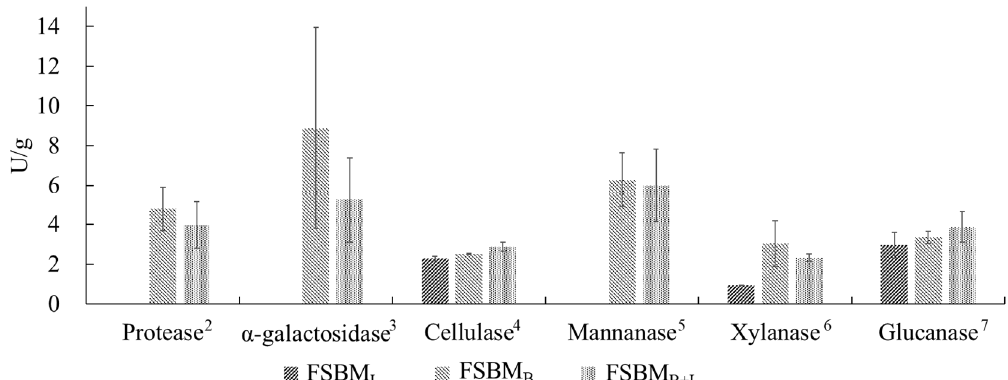
Figure 1. Enzymes activities of FSBM products. 1 Each value represents the mean ± standard deviation (n = 3). 2 One unit was defined as the hydrolysis of 1 mg mL − 1 azocasein to change the absorbance by 0.001. 3 One unit was defined as 2 mM p-Nitrophenol α -D-Galactopyranoside hydrolysis to release 1 µ M p-nitrophenol. 4 One unit was defined as the consumption of 5 mg mL − 1 CMC to generate 1 μ M of reducing sugar. 5 One unit was defined as the consumption of 3 mg mL − 1 locust bean gum to generate 1 μ M of D-mannose. 6 One unit was defined as the consumption of 10 mg mL − 1 beechwood xylan to generate 1 μ M of D-xylose. 7 One unit was defined as the consumption of 4 mg mL − 1 β -glucan to generate 1 μ M of reducing sugar. SBM: Soybean meal; FSBM L : commercial control; FSBM B : SBM one-stage fermented by Bv; FSBM B+L : SBM two-stage fermented by Bv and Lb.